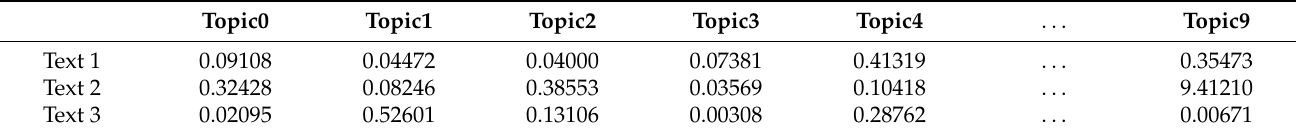
Table 5. Text-topic probability distribution file.